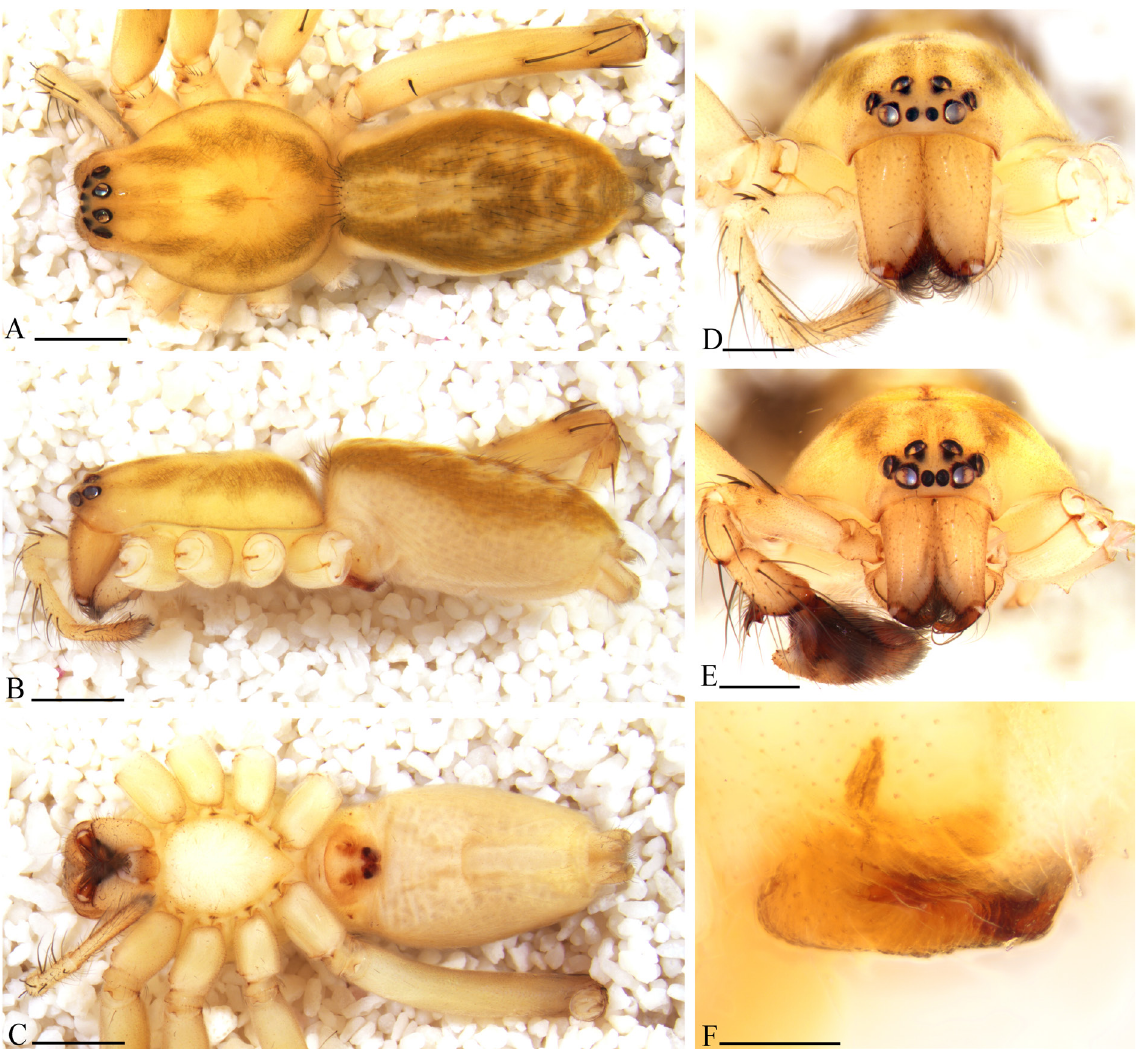
Fig. 13. Anyphaena urieli sp. nov. A–D . Holotype, ♀ (CNAN-T01542). E . Paratype, ♂ (CNAN-T01582). F . Paratype, ♀ (CNAN-T01581). A . Dorsal habitus. B . Lateral habitus. C . Ventral habitus. D . Prosoma, anterior view. E . Prosoma, anterior view. F . Epigynum, lateral view. Scale bars: A–C = 1.0 mm; D–E = 0.5 mm; F = 0.2